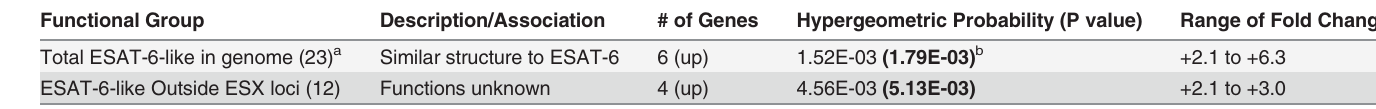
Table 7. Genes encoding ESAT-6-like proteins differentially expressed by M . tb in type II AEC. Functional